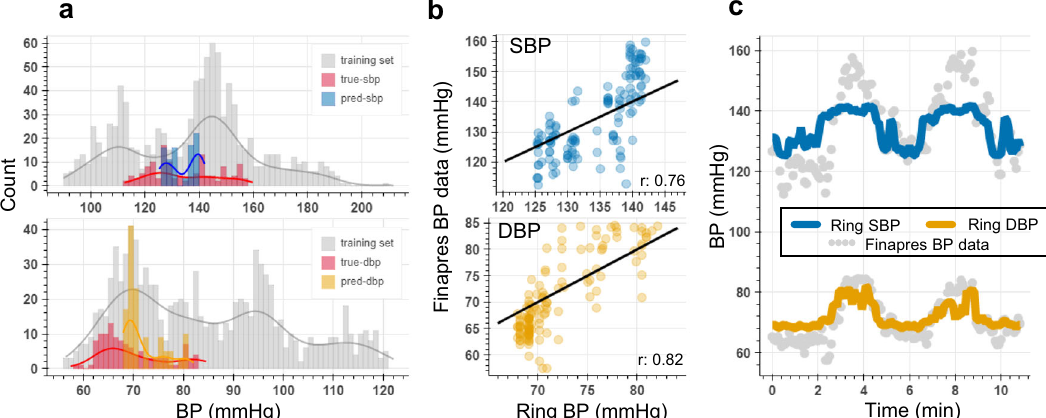
Fig. 8 Bioimpedance ring sensor leave-one-subject-out analysis for systolic (SBP) and diastolic (DBP) blood pressure estimation. a SBP (top) and DBP (bottom) data distribution training set involving participants S#6, S#7, and S#9 shown in gray color, true SBP, and DBP values in the test set for S#8 ’ s ’ data shown in red color, and predicted SBP (blue) and DBP (orange) values for S#8 ’ s data. b Correlation plots for SBP and DBP between true and predicted BP points, showing high correlation values ( r represents Pearson ’ s correlation coef fi cient between true and predicted BP values). c Time traces for SBP (blue line) and DBP (orange line) estimations with bioimpedance ring sensor for S#8, and the reference BP values (gray circles), where the model was trained on three other participants ’